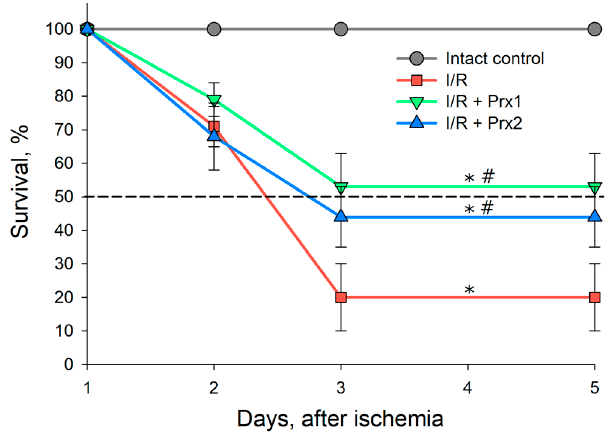
Figure 4. Survival of mice during 5 days after 30 min ischemia of both kidneys and subsequent reperfusion, and after injection of recombinant enzymes, Prx1 and Prx2, 15 min before ischemia ( n = 30 for each group). p ˂ 0.05 relative to the * intact control and # I/R.